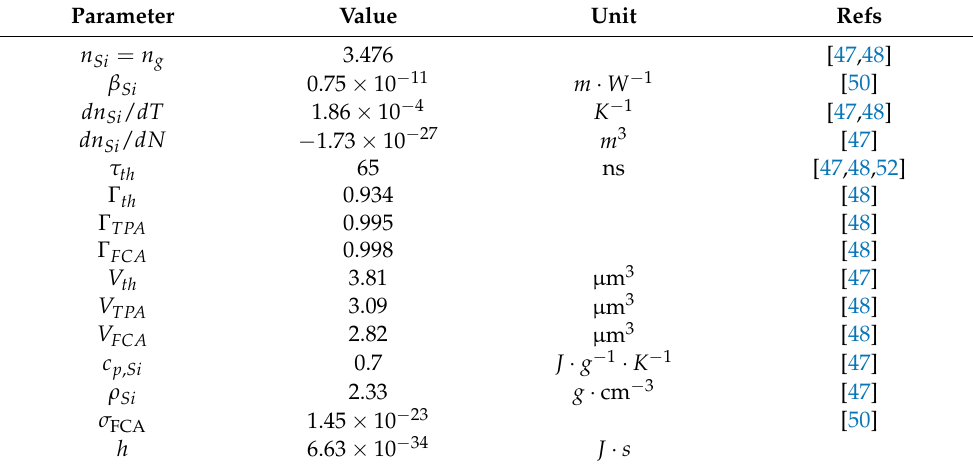
Table 2. Basic Parameters Used in MRR STDP.